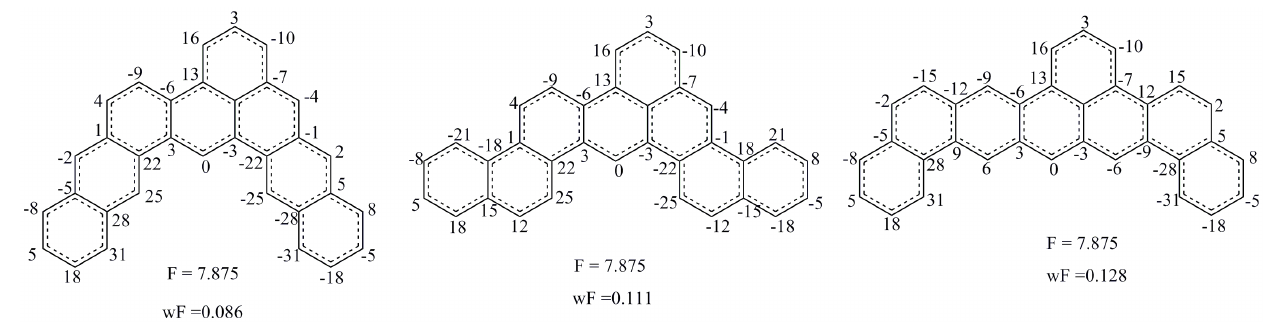
Figure 9. Three benzenoids composed of 8 benzene rings possessing the same F indexes vector.